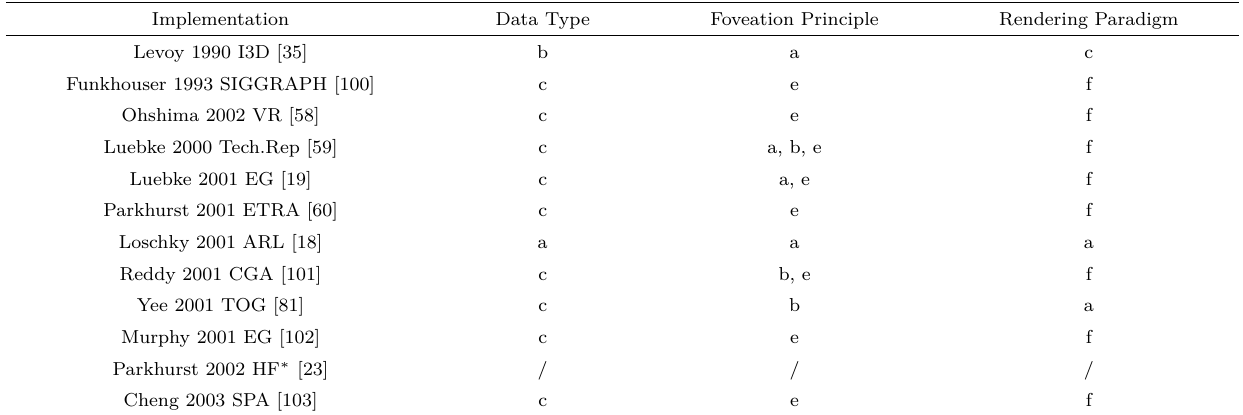
Table 3 Summary of foveated rendering technique implementations (*: survey, +: patent, -: cutting-edge equipment)